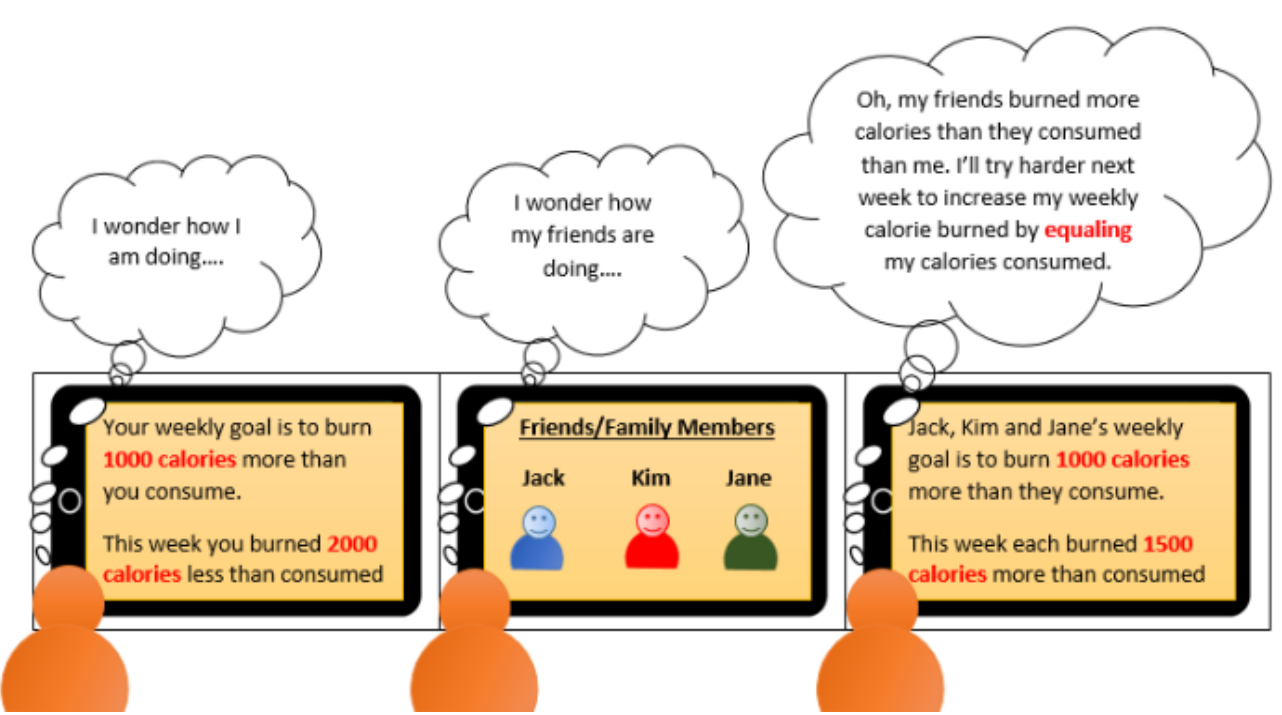
Figure A5. Low-fidelity storyboard illustrating the Social Comparison feature of the fitness app [30].